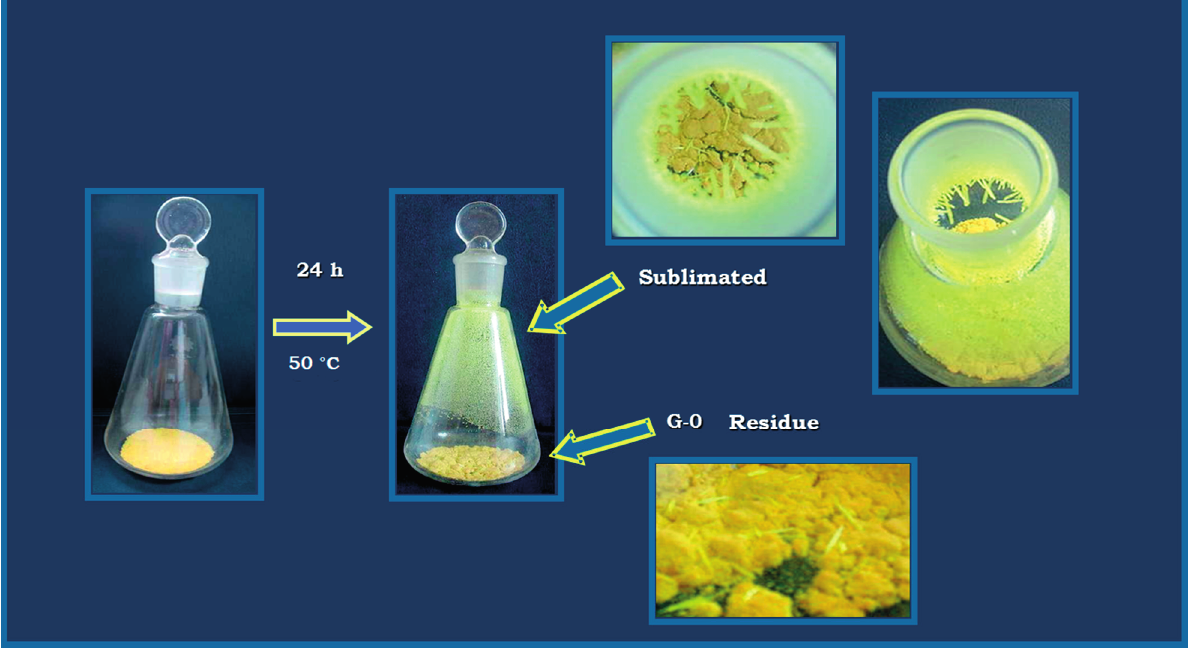
Figure 2. Formation of the sublimated 2-(2-nitrovinyl) furan